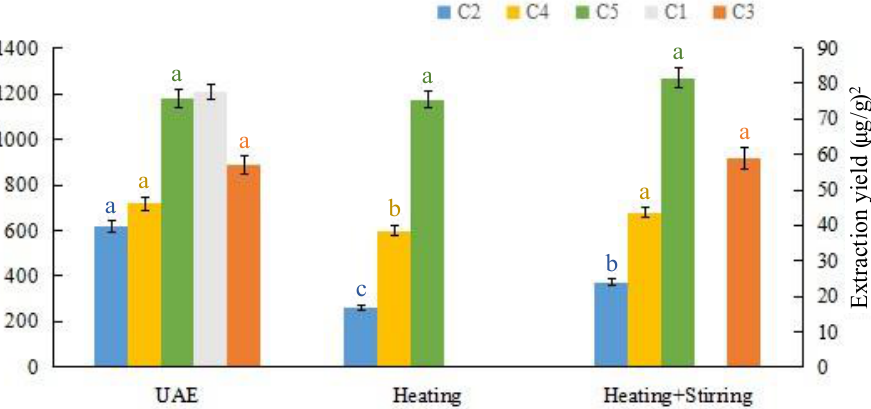
Figure 3. Comparison of the extraction efficiency between UAE and other extraction methods using DES-7. Different lowercase in columns of the same color represents a significant difference at p < 0.05. ( 1 Extraction yields of C2, C4 and C5; 2 Extraction yields of C1 and C3).